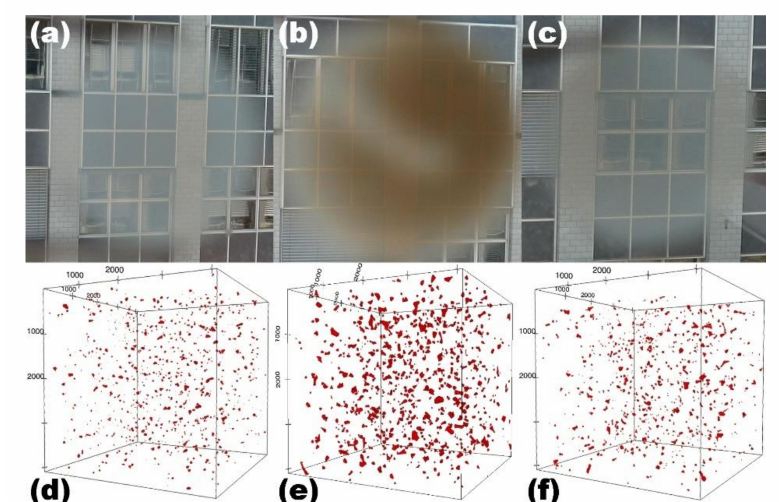
Figure 9. Sample images ( a – c ) and 3D-FIB tomography representations ( d – f ) of the porosity in the same samples at di ff erent treatment states: ( a , d ) as-sintered (sample C1); ( b , e ) after thermal treatment at 1150 ◦ C (sample C2); and ( c , f ) after thermal treatment followed by post-HIP at 1500 bar (sample C3). All samples have been sintered at the same conditions as sample C in Figure 8. The 3D-FIB pore reconstruction is of a 4.11 · 4.11 · 4.11 µ m 3 volume for all three samples. Note that the uncolored area in the middle of sample C2 ( b ) resulted from dislocation release into a crack present in the sample before thermal treatment [32]. (reprinted with the permission from Wiley-VCH).